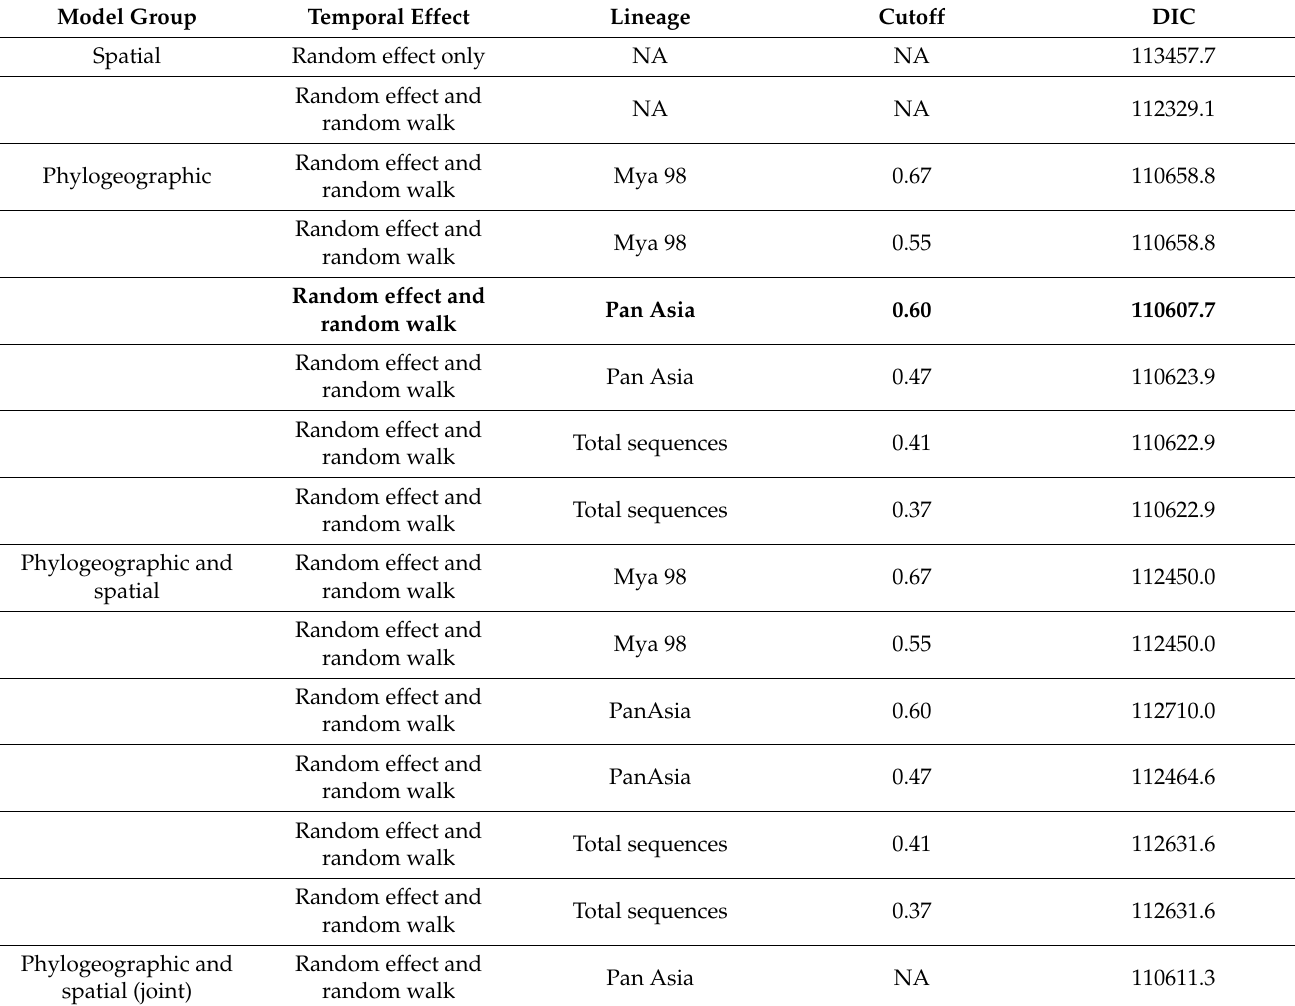
Table 1. Comparison of different model structures utilized for Bayesian space–time regressions of reported case counts. Phylogeographic matrices were tested with two different cutoffs (at median and 80% of median) to dichotomize the phylogeographic adjusted rate matrices. The best-fit structure is marked in